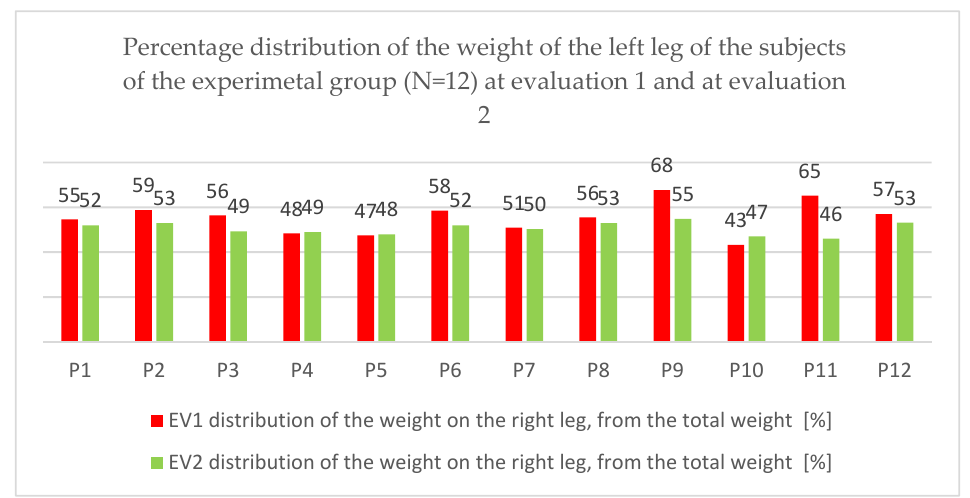
5.48 Table 7. The table of statistical indicators of the difference in percentage distribution of weight on the left leg. Statistical Indicators of the Resulting Difference (EV2-EV1) Bilateral Dependent Student t -Test Average